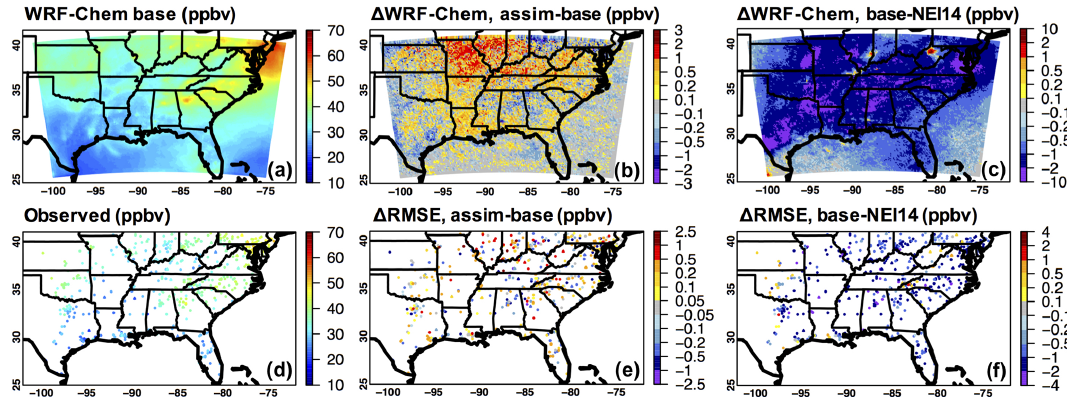
Figure 12. Period-mean (16–28 August 2016) daily maximum 8h average (MDA8) surface O 3 from (a) the WRF-Chem base case and (d) the EPA AQS (filled circles) and CASTNET (triangles) sites. The impact of the SMAP DA on WRF-Chem MDA8 O 3 and the associated RMSE changes are shown in (b, e) . The benefit of using NEI 2016 beta instead of NEI 2014 is indicated in (c, f)